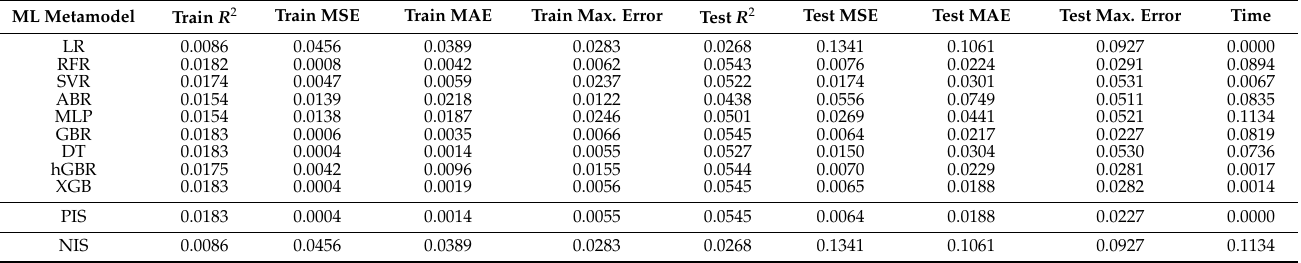
Table 5. Weighted normalized decision matrix for